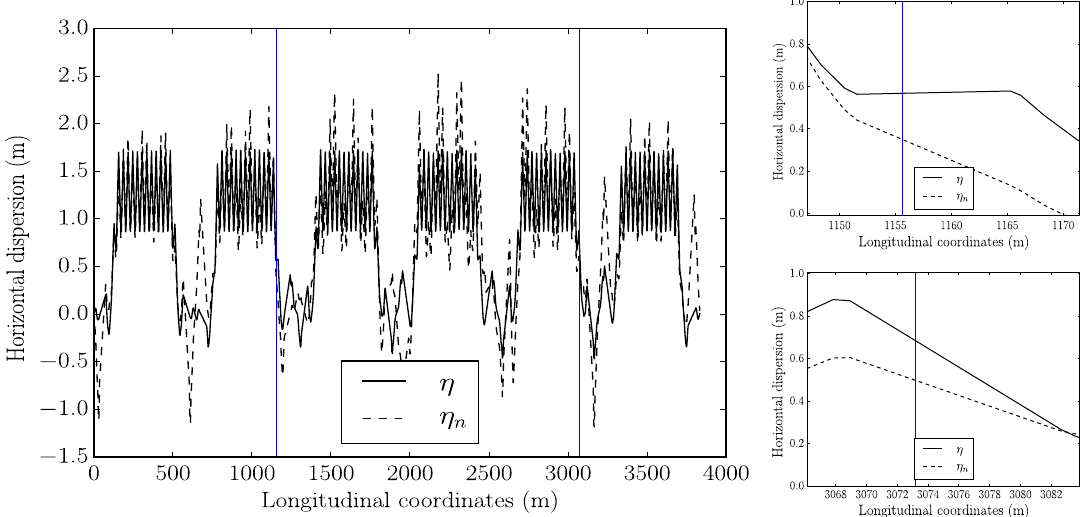
FIG. 2. Left plot: The model horizontal dispersion functions (the solid line) at top energy and the distorted horizontal dispersion functions (the dashed line) with the dispersion primes matched at the two Siberian snakes (located at the vertical lines) in the Blue ring. Right plots: Expanded view of the dispersion functions at the first snake (the upper plot) and the second snake (the lower plot). The lattice was designed for the 2017 polarized proton program at top